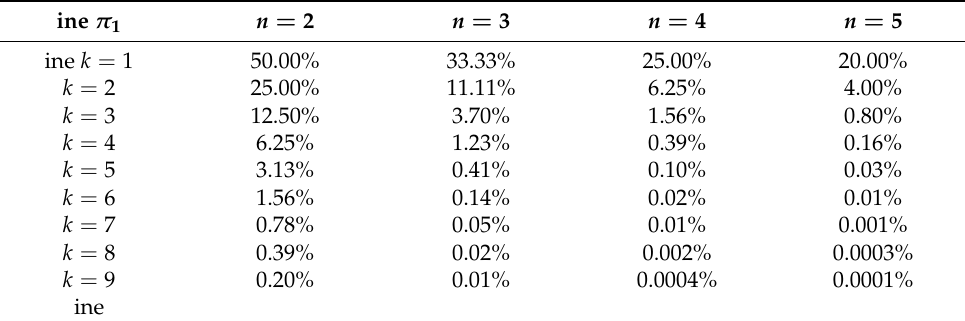
Table 5. The probability of correctly identifying individual trajectories ( π 1 ).